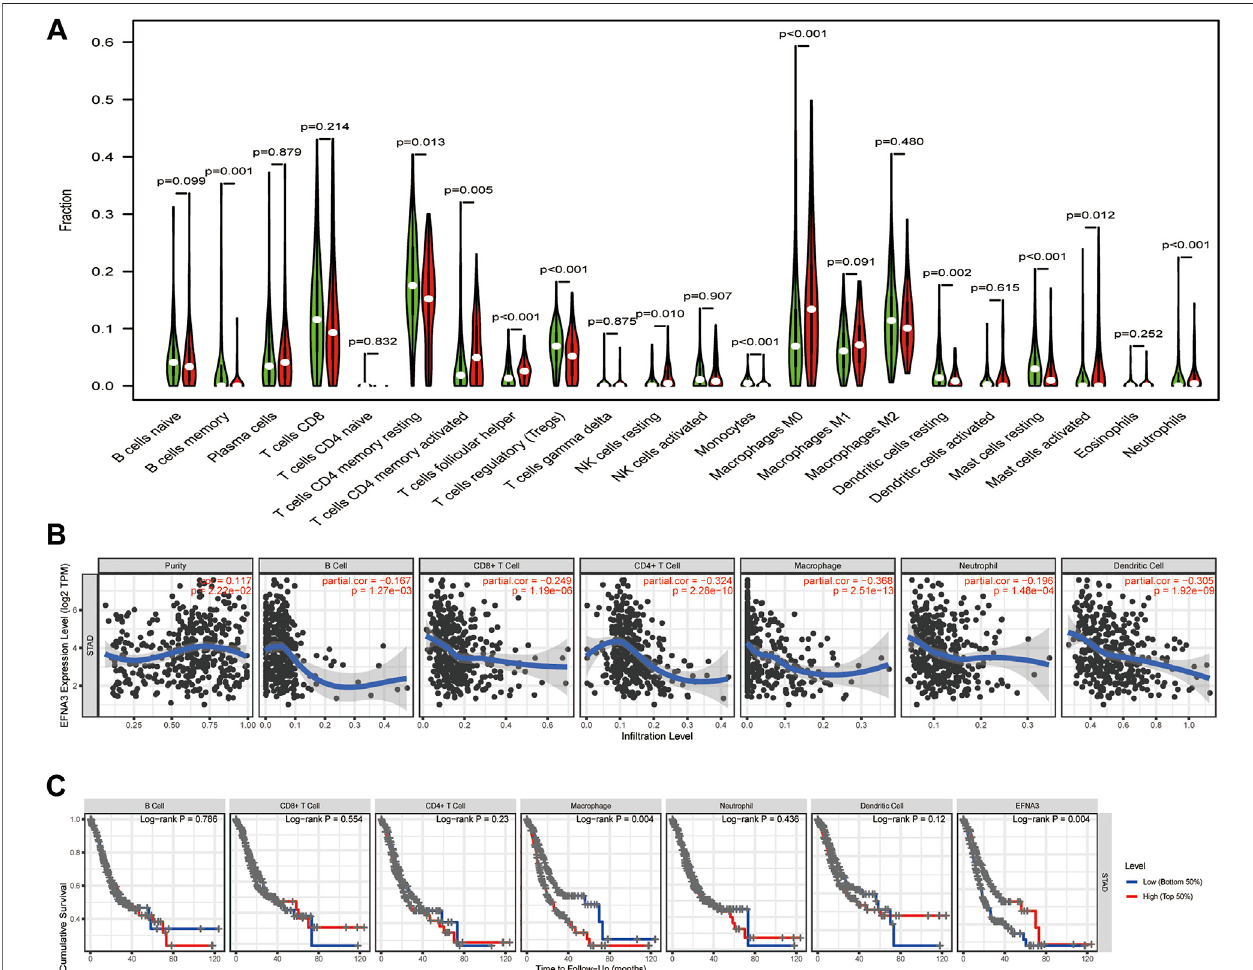
FIGURE4|(A) Proportion of22subpopulations ofimmunecells. (B) EFNA3expression levelwassigni fi cantlynegatively correlatedwithlevels ofin fi ltrating Bcells, CD8 + T cells, CD4 + T cells, macrophages, neutrophils, and DCs in GC. (C) Cumulative survival was related to macrophages and EFNA3 in